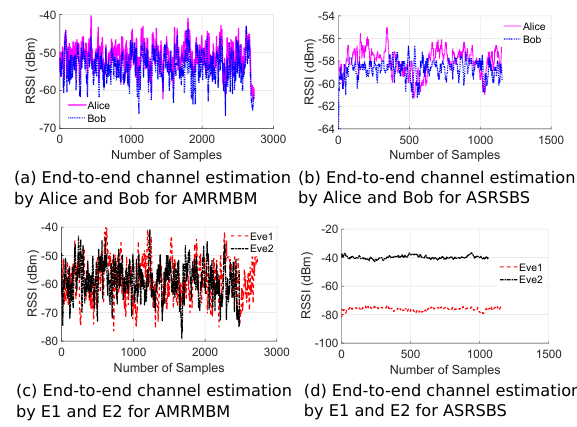
Figure 6: The channel estimations of Alice and Bob have high correlation. The eavesdropper’s channel estimations vary from those of legitimate